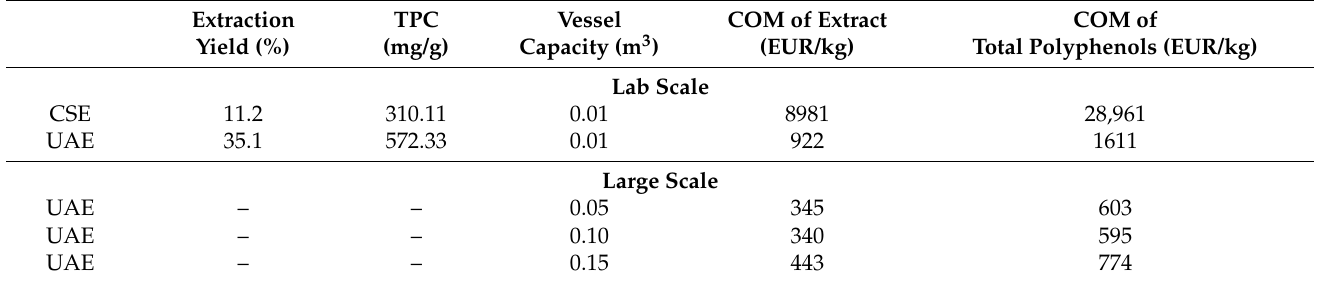
Table 4. COM of extract and TPC using CSE and UAE at lab and large